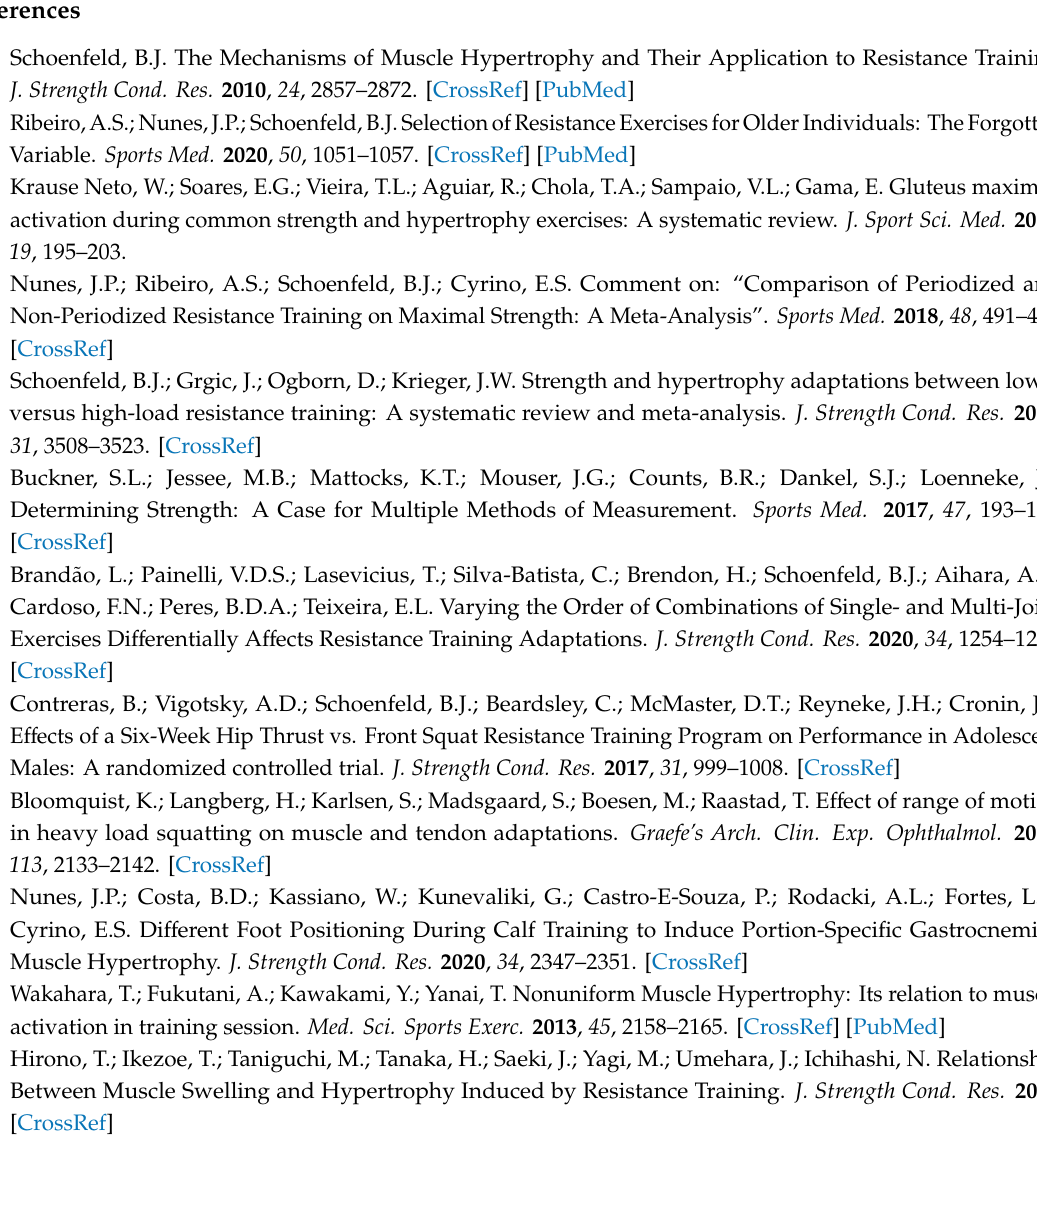
Figure S1: Overview of the measure of the thickness of biceps brachii